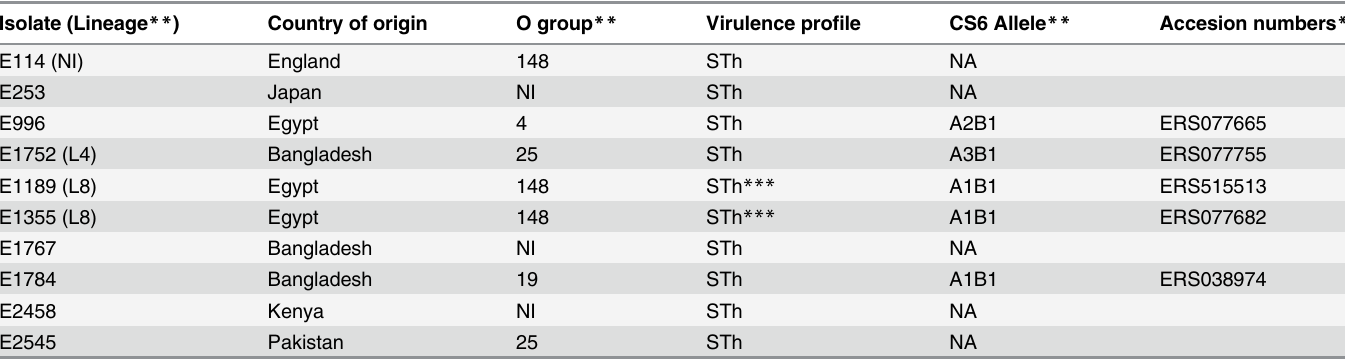
Table 2. CS6+STh expressing ETEC isolates used in this study *